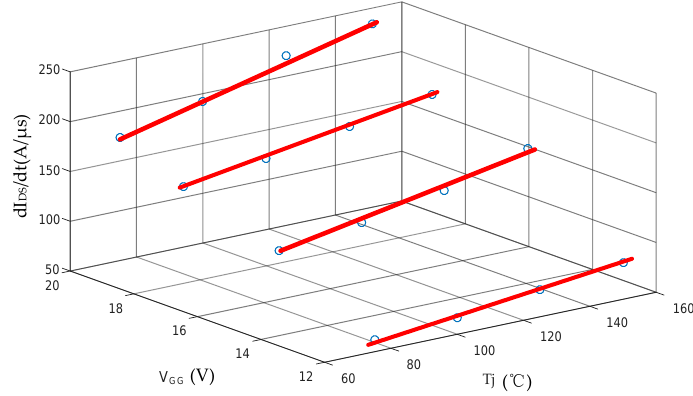
Figure 14. dI DS /dt values for different temperatures under four driving voltages.